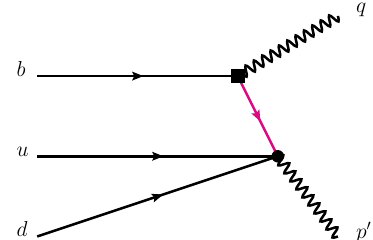
momentum |¯ n · p | ∼ O ((cid:2)) and n · p ∼ m (cid:2) of the two currents can be expanded around the light-cone x 2 (cid:10) 0. After contracting the u quark field and integrating out the coordinate, the correlation function at partonic level can be factorized into the convolution of the hard kernel and the LCDA of (cid:2) b baryon, as shown in the diagram of Fig.1.